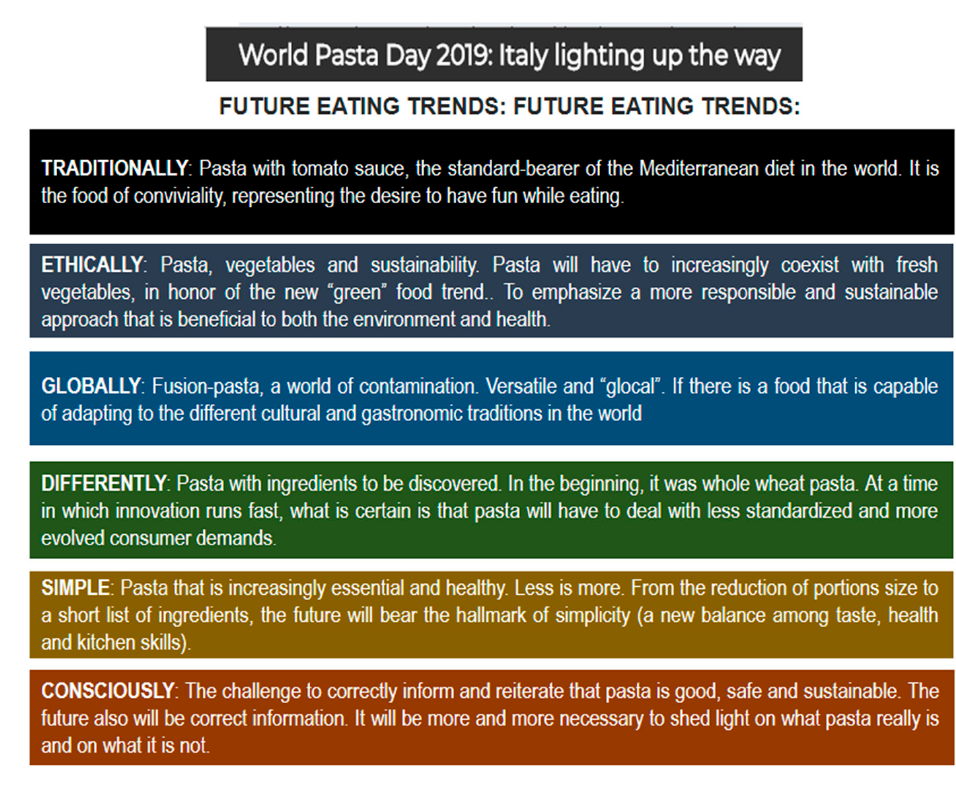
Figure 1. Trends that will shape the consumption of this globally appreciated food in the coming decades